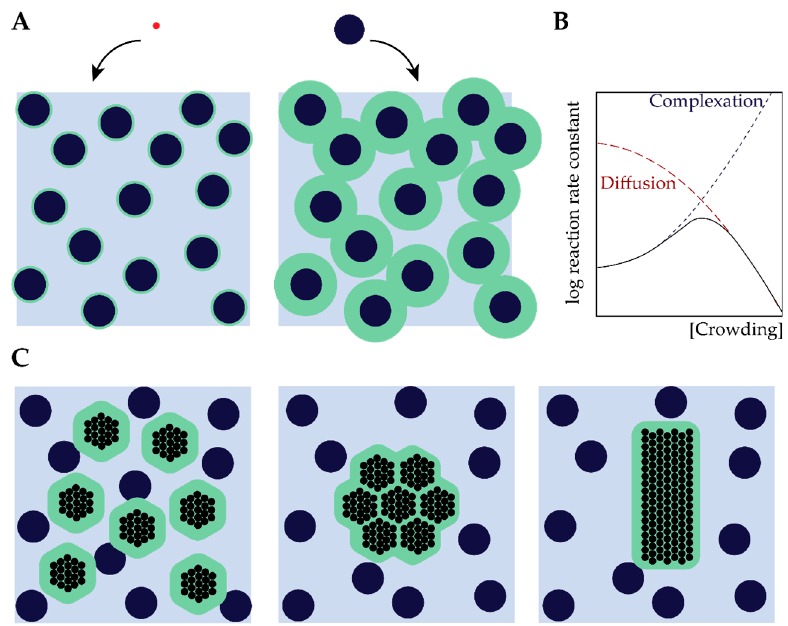
Figure 2. Excluded volume effect of crowding. ( A ) A small particle (red) experiences a smaller excluded volume than a large particle (black sphere). The blue area represents the free space for the particle; for a large particle the effective free volume is limited. ( B ) Many biochemical processes display a maximum rate at some optimum crowding, as crowding enhances complexation (blue curve), but it also reduces diffusivity (red curve) ( C ) The effect of depletion forces, bringing molecules together reduces the total excluded volume. (Figure 2A is adapted from Minton 2001 [23], Figure 2B is adapted from Ellis 2001 [3], and Figure 2C is adapted from Richter 2008 [24]).